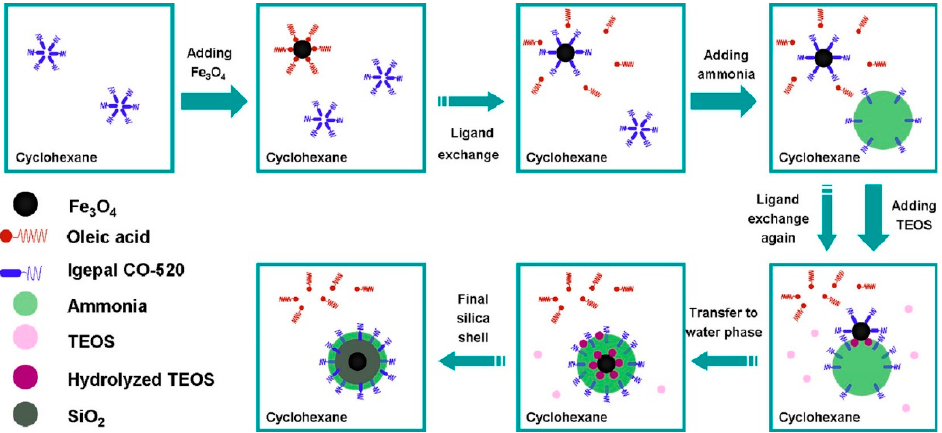
Figure 7. Mechanism of coating of IO NPs with silica via microemulsion [16]. Reprinted with permission from [16].